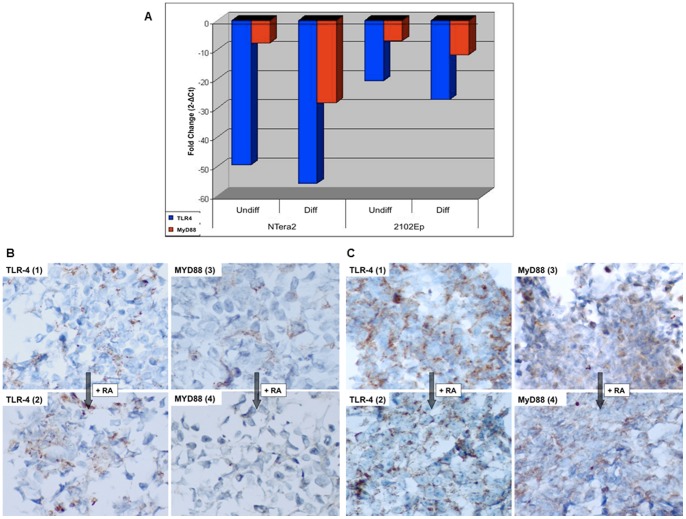
TLR4 and MyD88 expression in undifferentiated and retinoic acid (RA)-differentiated NTera2 and 2102Ep cells.
A, qPCR data: MyD88 expression is down-regulated upon NTera2 differentiation, with minimal changes in TLR4; in contrast 2102Ep cells avoid differentiation and maintain both TLR4 & MyD88 expression (fold changes shown are proportional to internal control gene GAPDH and calculated via the 2−ΔΔCt method). B, TLR4 and MyD88 protein expression in NTera2 cells: TLR4 staining was unchanged following differentiation (left panel); MyD88 staining in undifferentiated NTera2 cells showed significantly reduced staining after differentiation (right panel) (all 40x). C, TLR4 and MyD88 expression in 2102Ep cells: minimal changes in TLR4 (left panel) or MyD88 (right panel) were observed following RA-treatment (all at 40x).